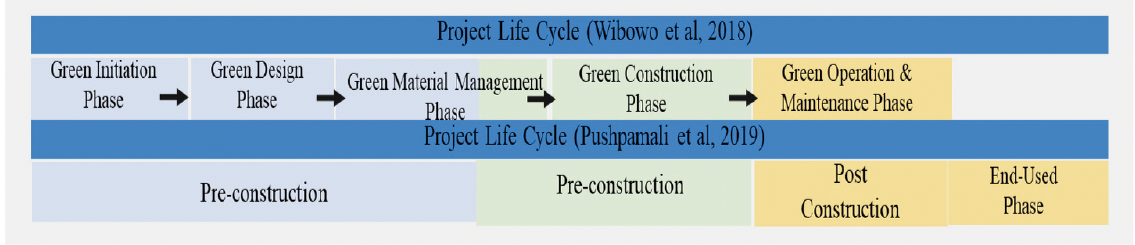
Figure 9. Project Life Cycle &